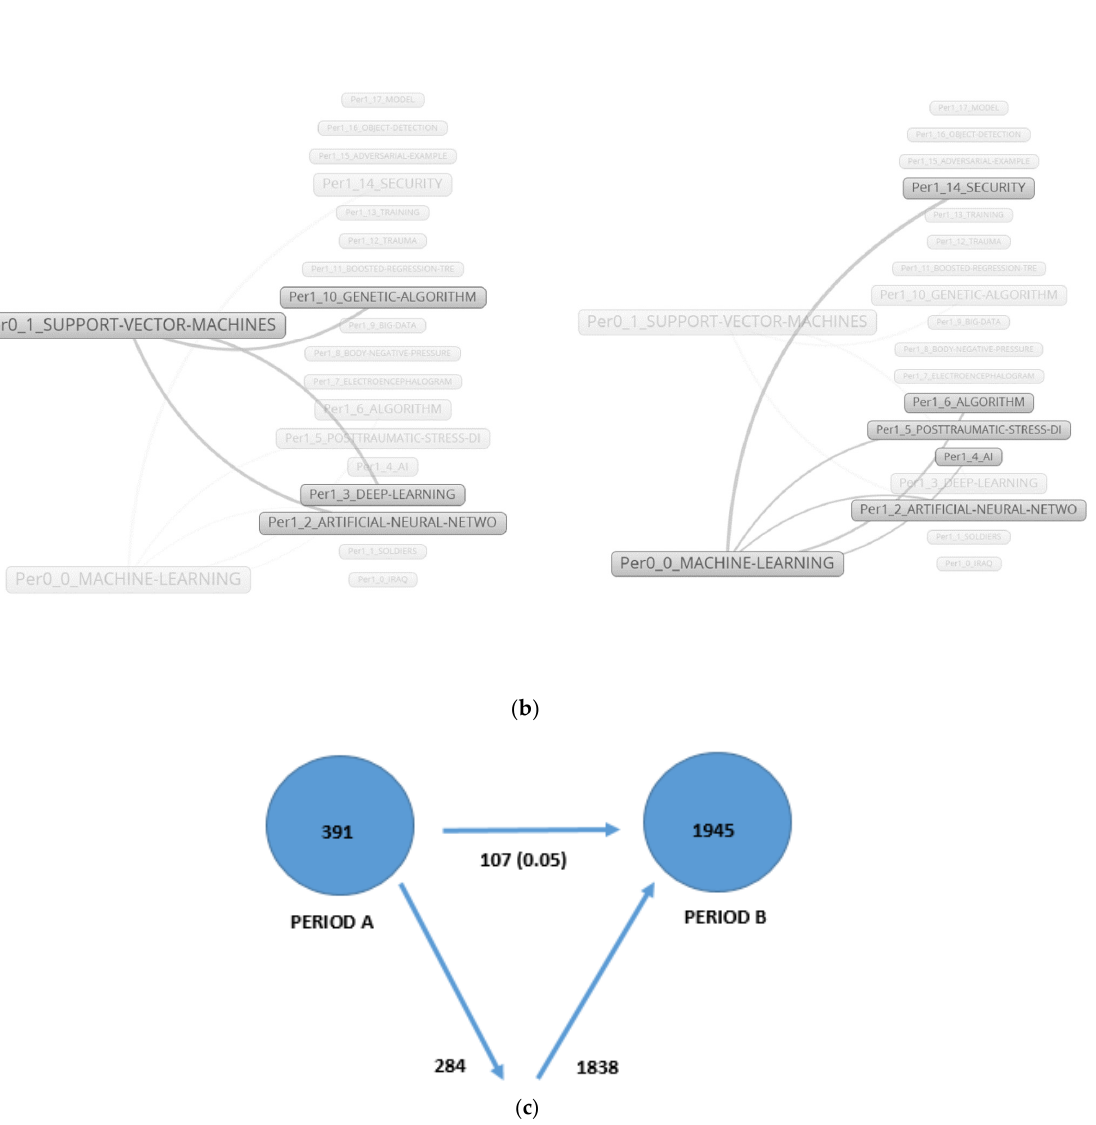
Figure 7. Periods of analysis ( a ) and evolution ( b ) and overlay diagram ( c ). Period to 2015